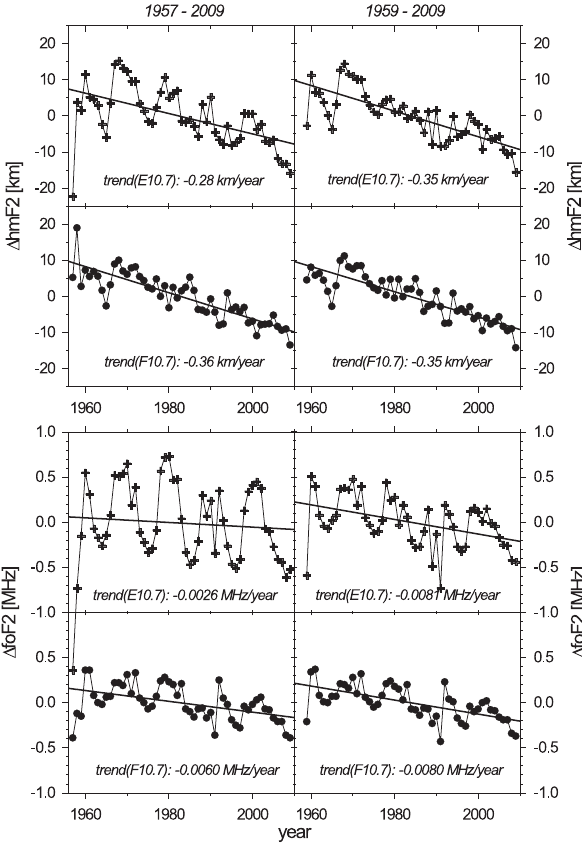
Fig. 9. Long-term trends from ionosonde observations at Juliusruh for two different data intervals (left column: 1957–2009, right col- umn: 1959–2009). In the upper part hm F2 data are shown, in the lower part fo F2 data. Solar indices used: F10.7 (dots) and E10.7